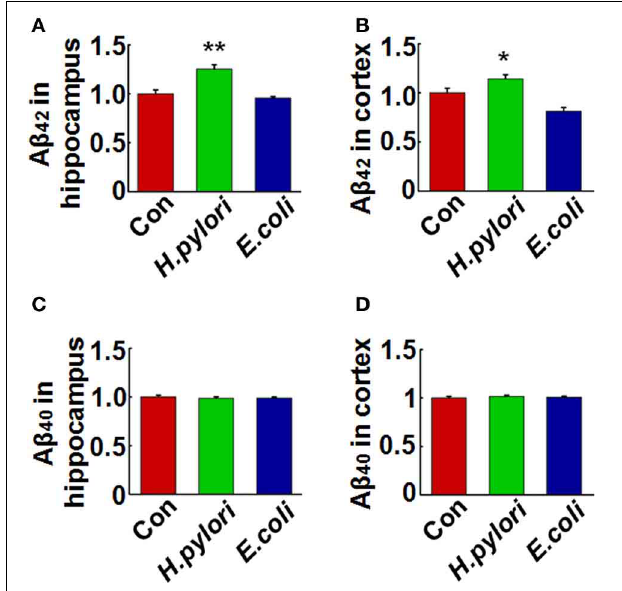
FIGURE 3 | Intraperitoneal injection of H. pylori filtrate causes A β 42 elevation in rat brains. SD rats were intraperitoneally injected with H. pylori filtrate, E.coli filtrate or DMEM/Opti-MEM medium (280 μ l/rat/day) for 7 days as described in Figure 1A .The rats were then anesthetized and decapitated and the levels of A β 42 and A β 40 in the hippocampus and cortex were measured by ELISA (A–D) . A β 42 levels both in the hippocampus ( p = 0 . 002, F = 20 . 142) and cortex ( p = 0 . 045, F = 16 . 637) were significantly increased in rats injected with H. pylori filtrate. ∗ p < 0 . 05, ∗∗ p < 0 . 01 vs. control group (mean ± SD, n = 9). ( Figure 4 , p = 0 . 0003, F = 45 . 103). Correspondingly, the